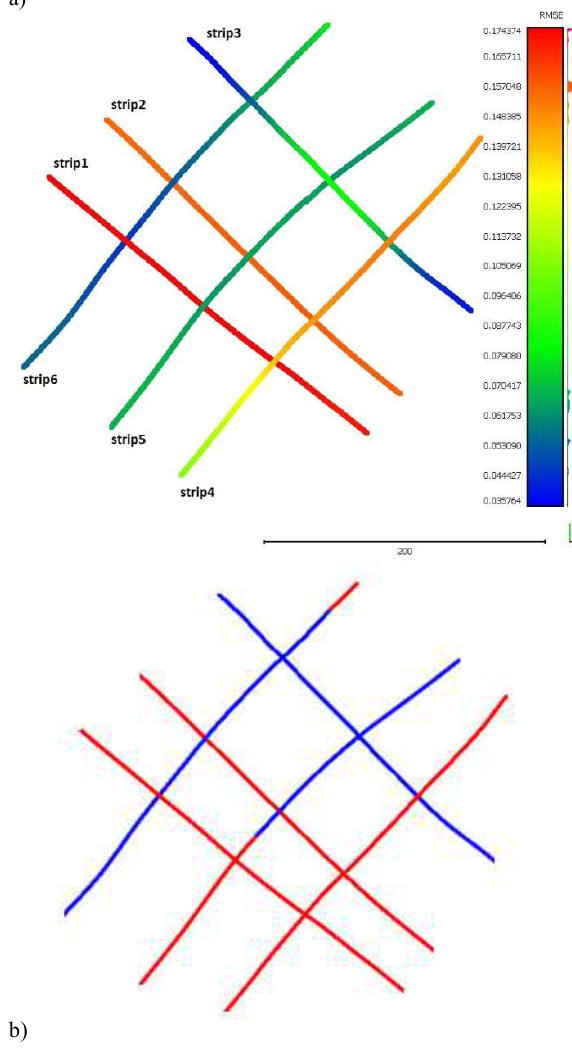
Figure 7 . Trajectory accuracy for 6 strips (a) and GNSS solution . Trajectory accuracy for 6 strips (a) and GNSS solution status (b): blue - RTK fixed, red RTK fixed, red - RTK